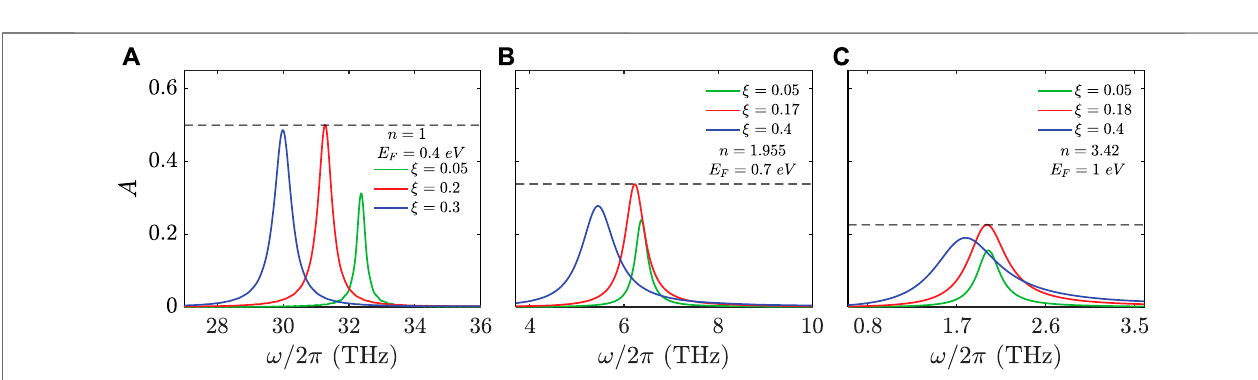
FIGURE 4 | Absorption spectra of GCWA with same duty ratio but different geometric parameters. (A) Absorption spectra for GCWAs with the same P x (4.93 μ m) and P y (2.46 μ m)butdifferent L and W . (B) AbsorptionspectraforGCWAswiththesame L (2 μ m)and W (1 μ m)butdifferent P x and P y . (C) AbsorptionspectraforGCWA with different P x , P y , L and W oscillating at 3 – 28 THz. The duty ratio of GCWAs is fi xed to ξ (cid:2) 0 . 165. All the spectra exhibit maximum absorptions, con fi rming the applicability of the QCMT.